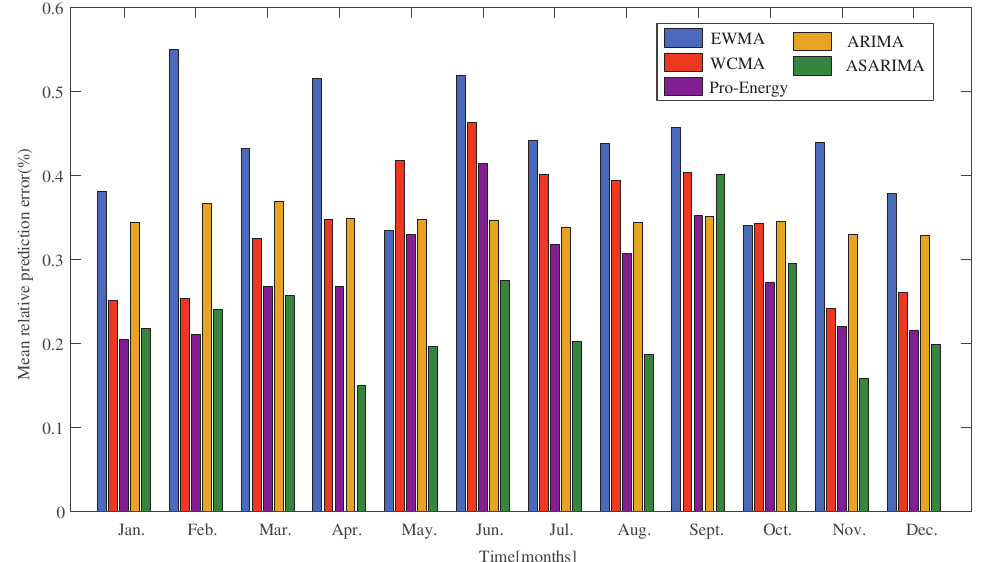
Figure 9. Comparison of the monthly mean relative prediction error of five algorithms on January 2018 to Dececember